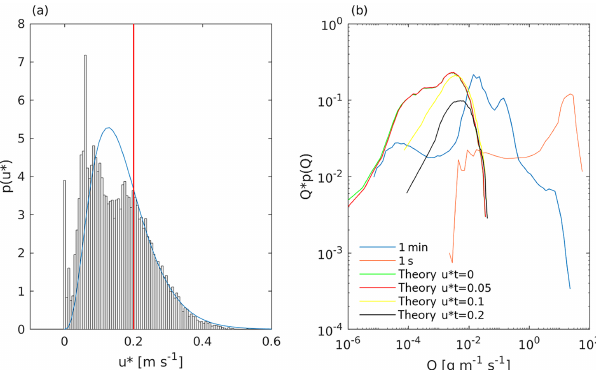
Figure 5. (a) Probability density functions of friction velocity, p(u ∗ ) , plotted against u ∗ (bars). To compute p(u ∗ ) , u ∗ 1min is used; a Weibull distribution (blue line) is fitted to p(u ∗ ) ; the red line marks the assumed threshold friction velocity. (b) Probability density function of Q , in Q · p(Q) , estimated using Q 1min (blue) and Q 1s (dark red) and using Eq. (13) assuming several u ∗ t val- ues ( u ∗ t = 0.0ms − 1 , green; 0.05ms − 1 , red; 0.1ms − 1 , yellow; 0.2ms − 1 ,